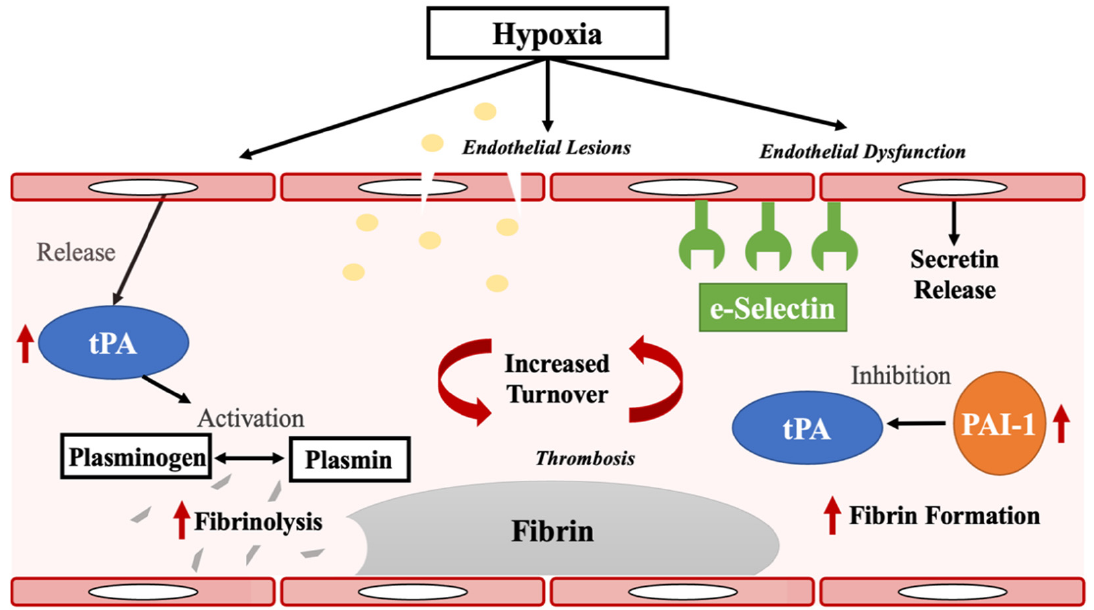
Figure 3. Proposed mechanisms in the relationship between obstructive sleep apnea, PAI-1, tPA, and sE-Selectin. Hypoxia in sleep apnea causes endothelial damage or injury. This is associated with (1) increased release of sE-selectin; and (2) stimulation of local fibrin aggregation. Increased tPA and PAI-1 activity reflects enhanced fibrin formation/fibrinolysis turnover, perhaps contributing to the known increased risk of stroke in sleep apnea.